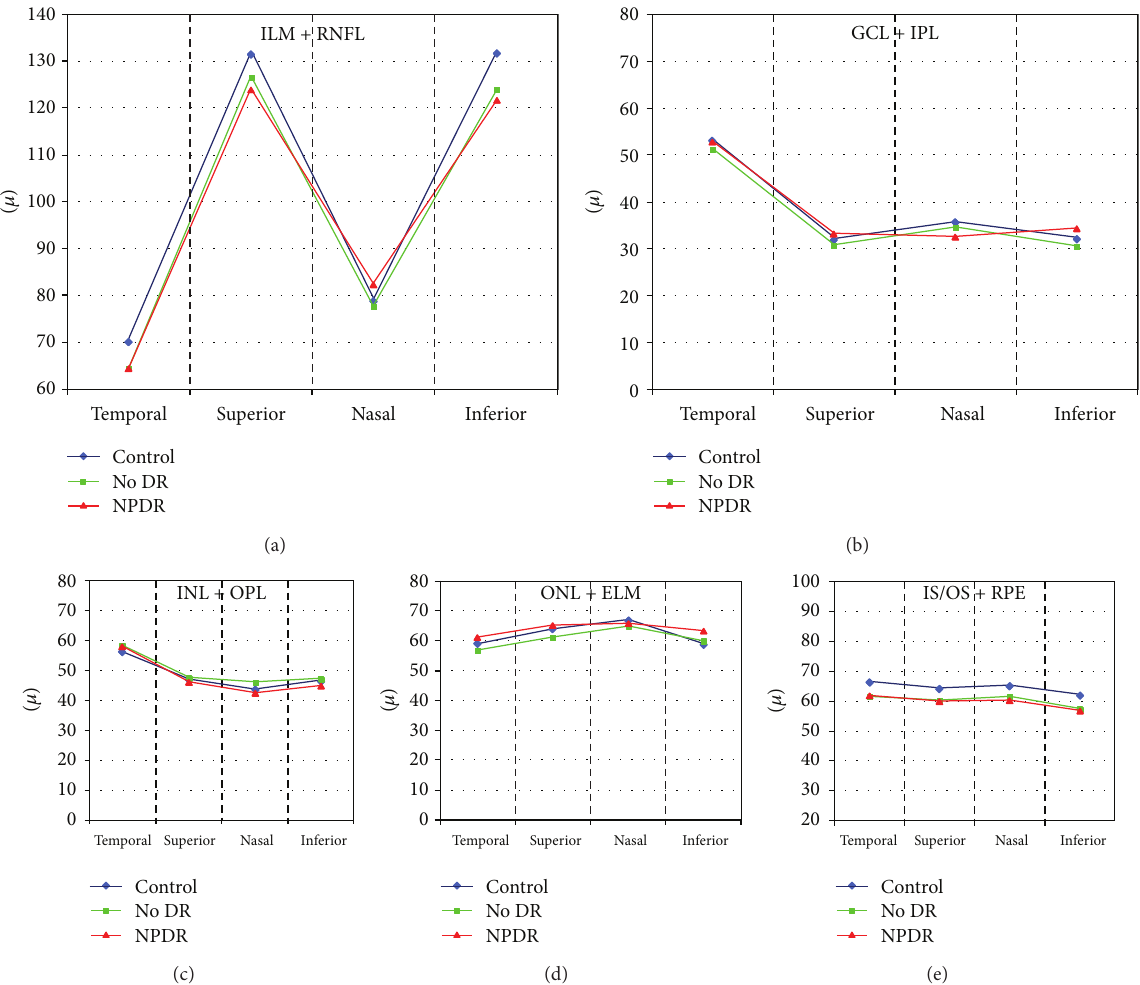
Figure 3: Graphs showing specific retinal layer thickness in normal subjects (control), diabetics without retinopathy (no DR), and diabetics with nonproliferative diabetic retinopathy (NPDR) determined automatically by spectral domain OCT in 4 peripapillary areas (temporal, superior, nasal, and inferior). (a) Inner limiting membrane + nerve fibre layer (ILM + RNFL); (b) ganglion cell layer + inner plexiform layer (GCL+IPL);(c)inner nuclear layer +outerplexiform layer (INL+ OPL);(d)outer nuclear layer + external limitingmembrane (ONL+ ELM); and (e) inner segment/outer segment photoreceptor layer + retinal pigment epithelium (IS/OS + RPE). There is no significant difference in the retinal layer thickness among the controls, no DR, and NPDR